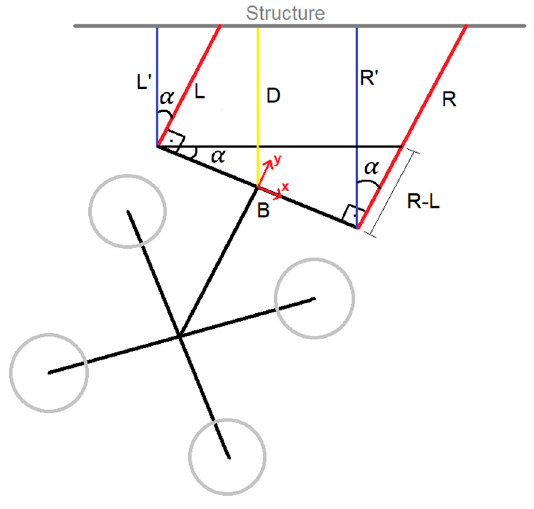
Figure 5. Trigonometric relationship between the measured distances and the UAV pose relative to the structure.